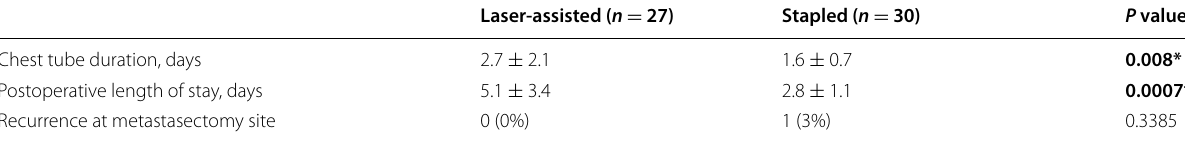
Table 4 Postoperative recovery